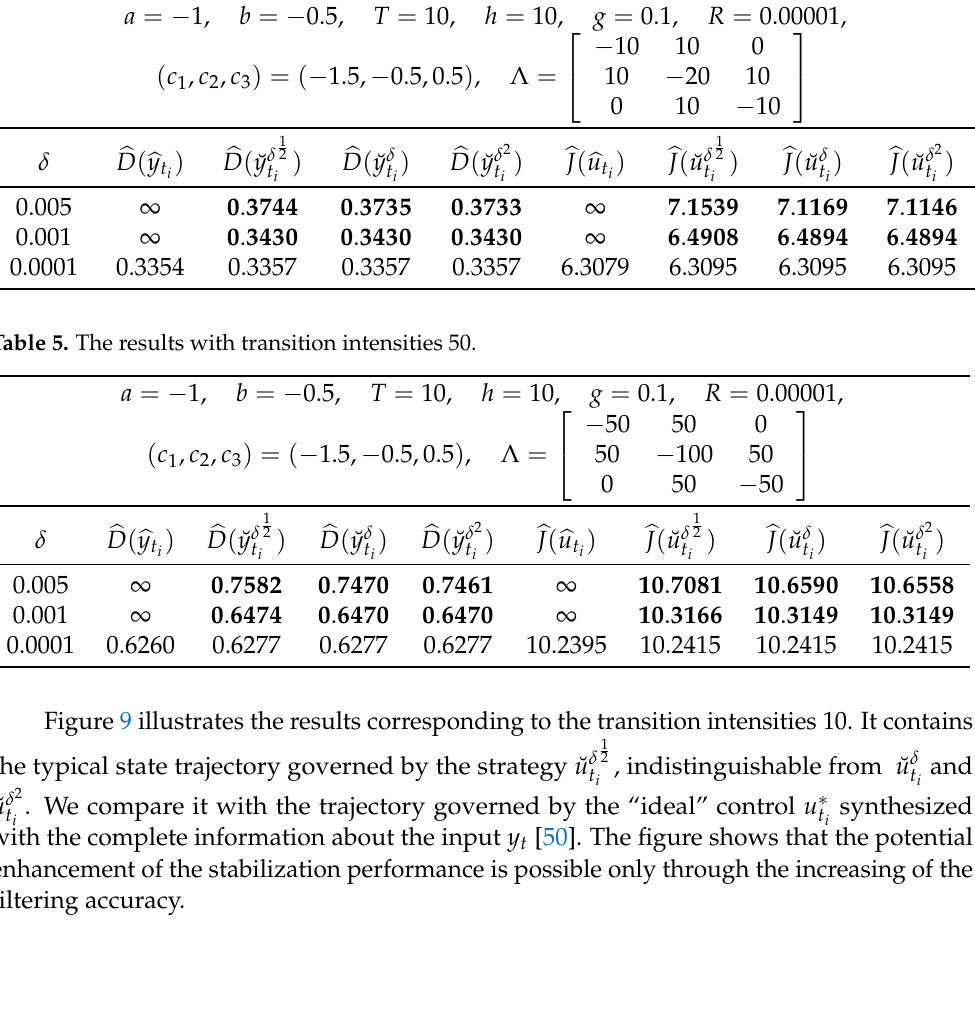
Table 4. The results with transition intensities 10.